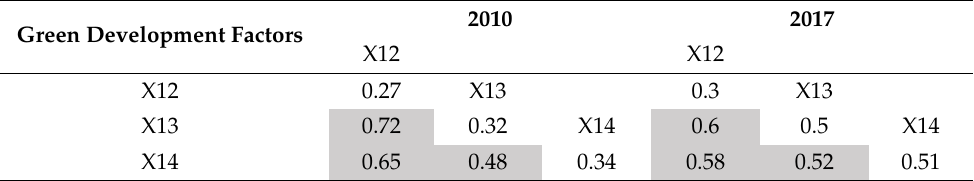
Table 5. Interaction effects of Green Development factors on PM 2.5Cement . The gray shaded items are the top three values in the two years. X12–14 are the Green Development factors found in Table 1. Green Development Factors